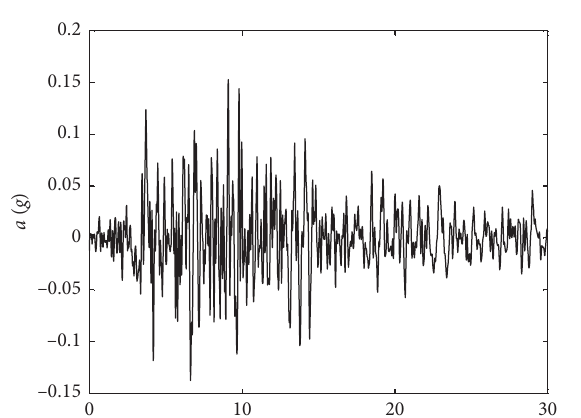
Figure 5: El Centro seismic wave.